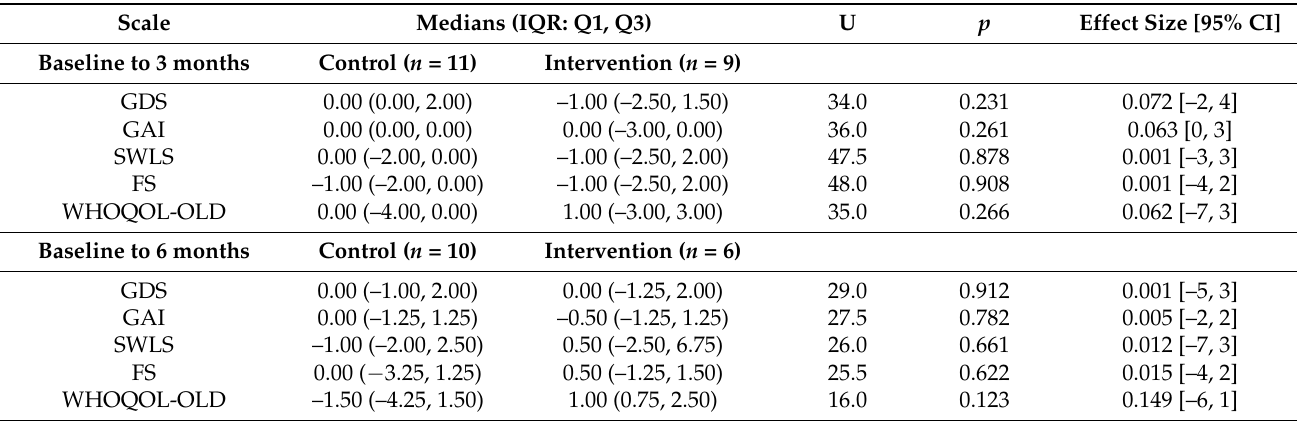
Table 3. Between-group differences for change in outcome scores from baseline to 3 months and baseline to 6